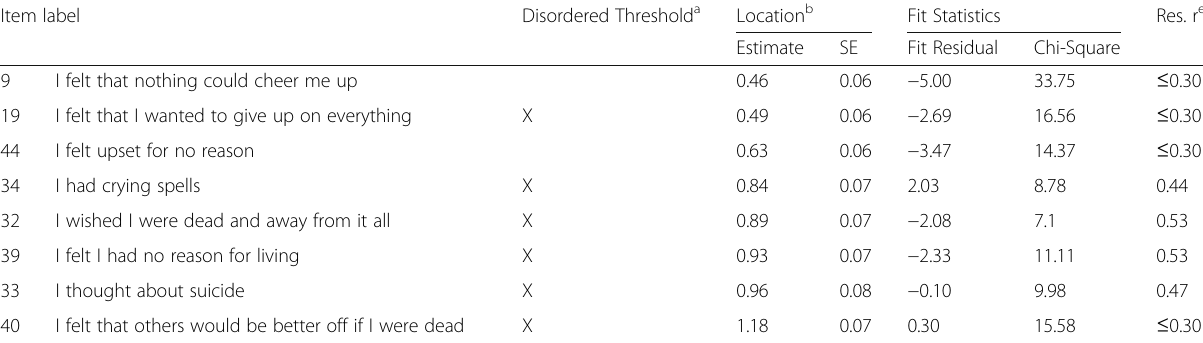
Table 2 PROMIS 51 Thresholds ordering, item location estimates, item fit statistics and item dependency (items ordered by location) (Continued)